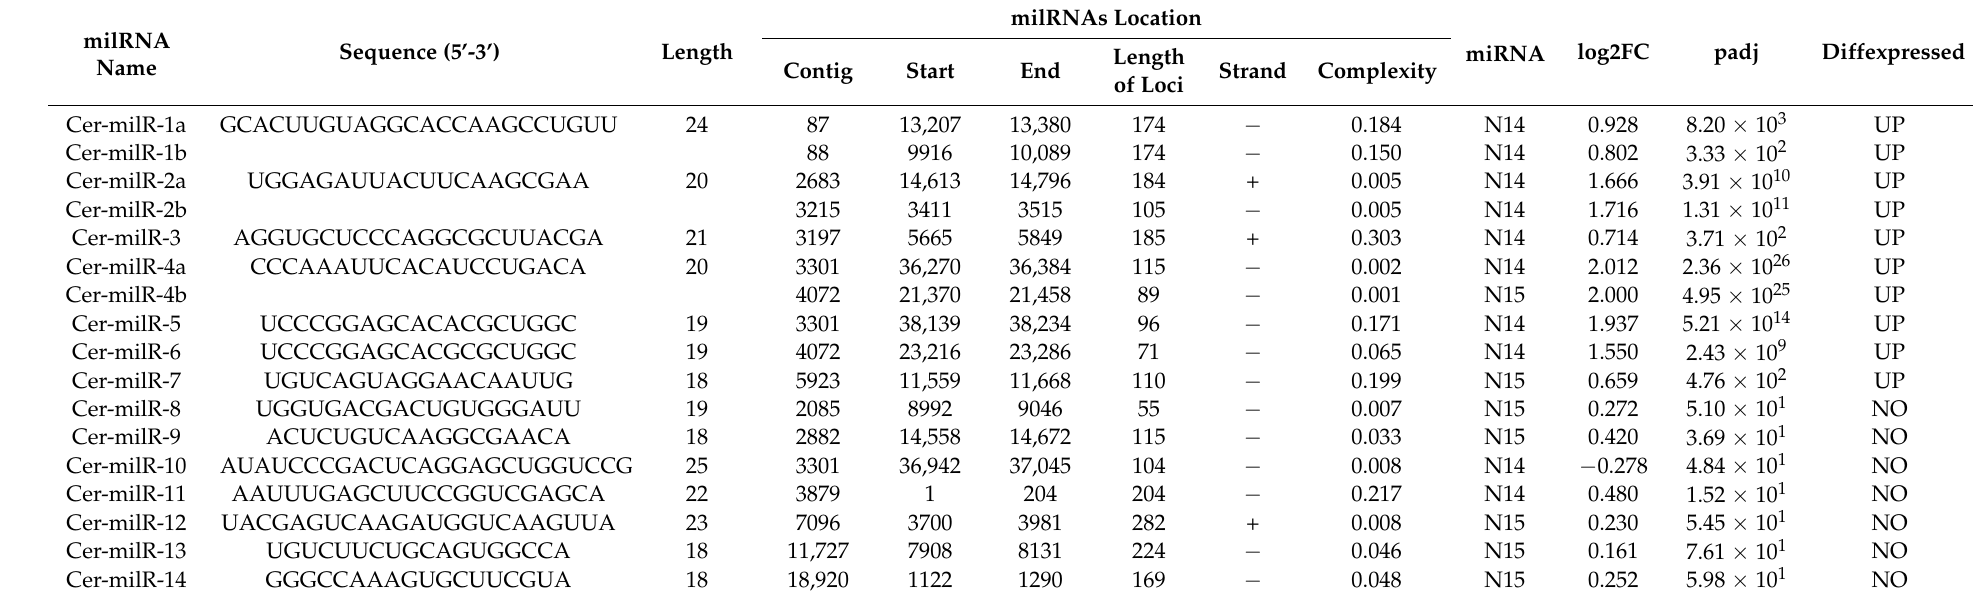
Table 5. Ceratobasidium C02 milRNA candidates identified by high-throughput